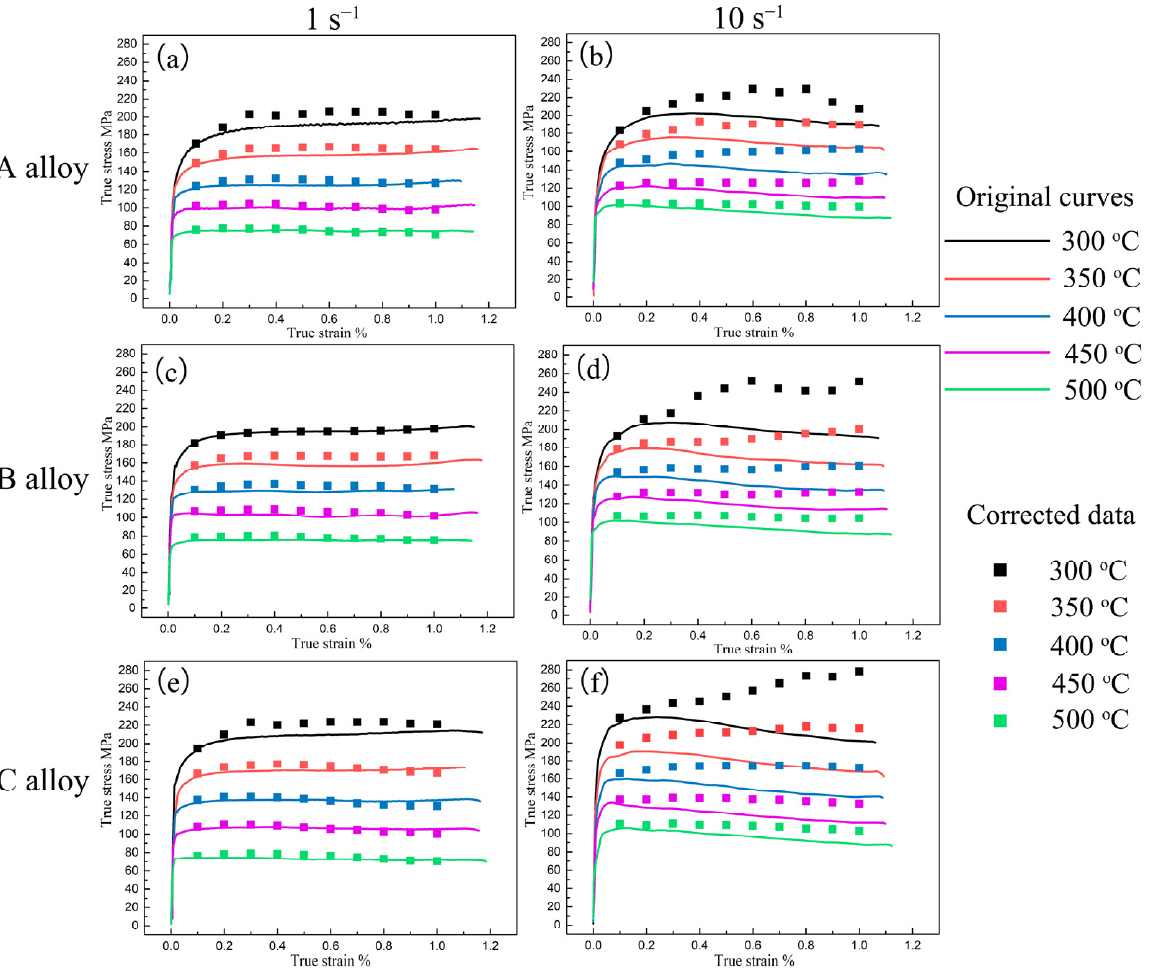
Figure 5. Original flow stresses and adiabatic temperature corrected data of ( a ) AA5182, 1 s − 1 , ( b ) AA5182, 10 s − 1 , ( c ) AA5182-0.05Sc-0.1Sc, 1 s − 1 , ( d ) AA5182-0.05Sc-0.1Sc, 10 s − 1 , ( e ) AA5182-0.1Sc-0.1Sc, 1 s − 1 , and ( f ) AA5182-0.1Sc-0.1Sc, 10 s − 1 .